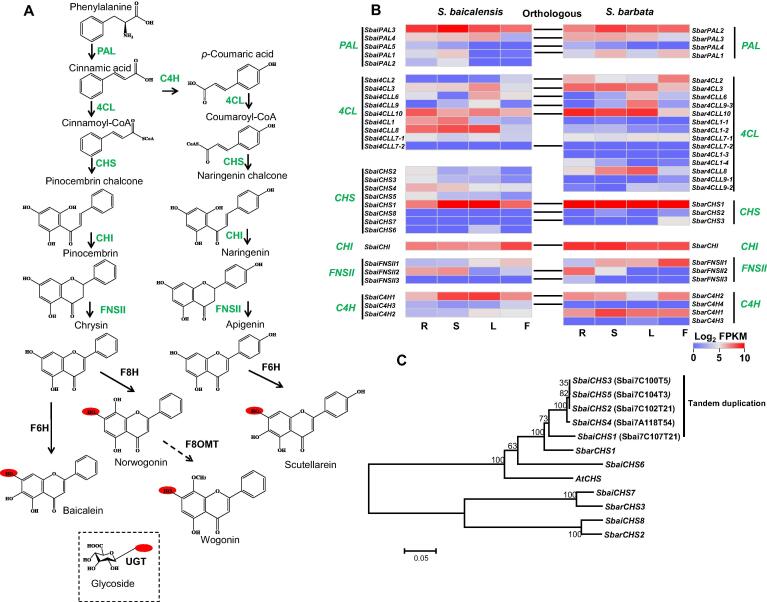
Conserved flavonoid biosynthesis and species-specific gene expansion in ScutellariaA. Genes related to the biosynthesis of flavones and their glycosides. The red ovals represent the hydroxyl groups that can be glucosylated by UGT. The dashed box means the glycoside. B. The expression profile and orthologous gene pairs of flavone biosynthetic genes in S. baicalensis and S. barbata. C. Tandem duplication and phylogenetic analysis of CHS genes. The phylogenetic tree was constructed based on maximum likelihood method. PAL, phenylalanine ammonia lyase; C4H, cinnamate 4-hydroxylase; 4CL, 4-CoA ligase; CHS, chalcone synthase; CHI, chalcone isomerase; FNSII, flavone synthase II; F6H, flavone 6-hydroxylase; F8H, flavone 8-hydroxylase; UGT, UDP-glycosyltransferase; F8OMT, flavone 8-O-methyltransferase.